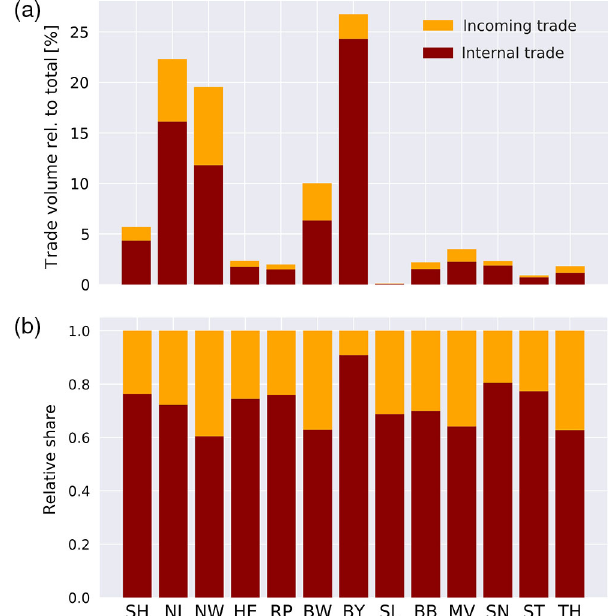
FIG. 13. Error estimation after restricting trade to the federal states. (a) Intrastate trade in terms of trade volume relative to total trade as red bars. Yellow bars on the top indicate the fraction of incoming animals. All bars together sum up to 100%. (b) Sum of internal and incoming trade volume normalized for each federal state. See Table I for a list of states and their abbreviations.